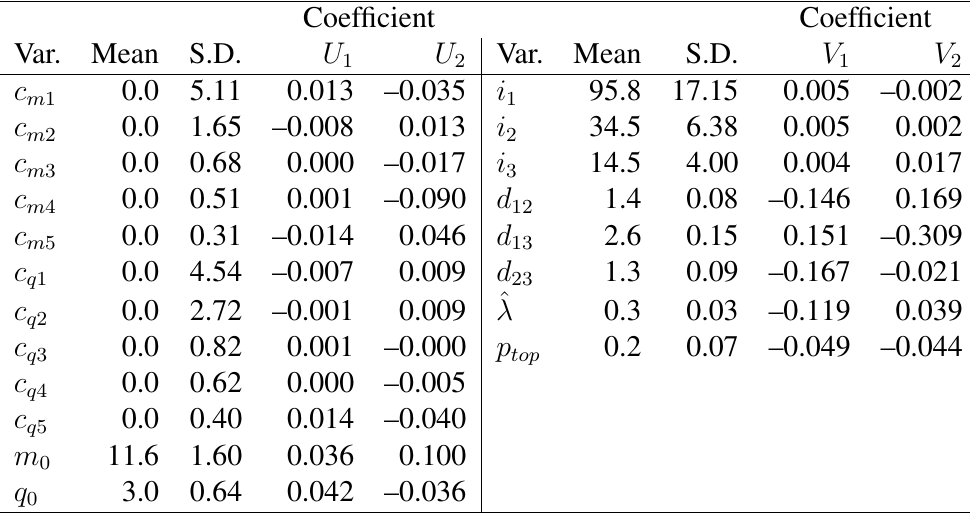
Table 3. Coefficients from the canonical correlation procedure for the first two canonical variates of both datasets. Mean and standard deviation of all variables are included for reference.